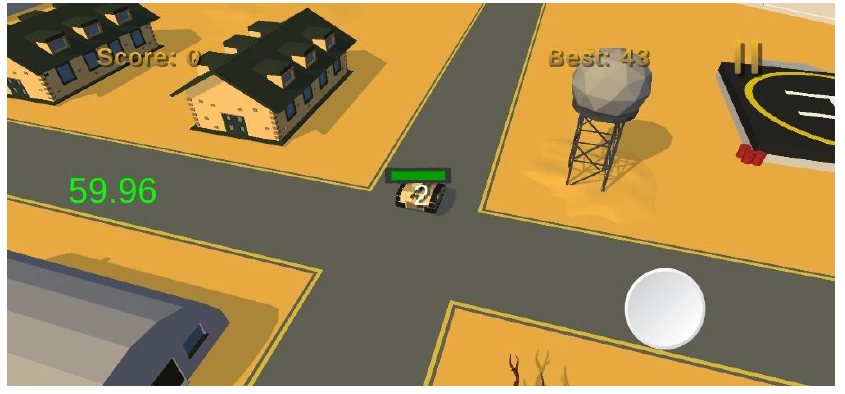
Figure 14. Beginning of the optimized version of the game.